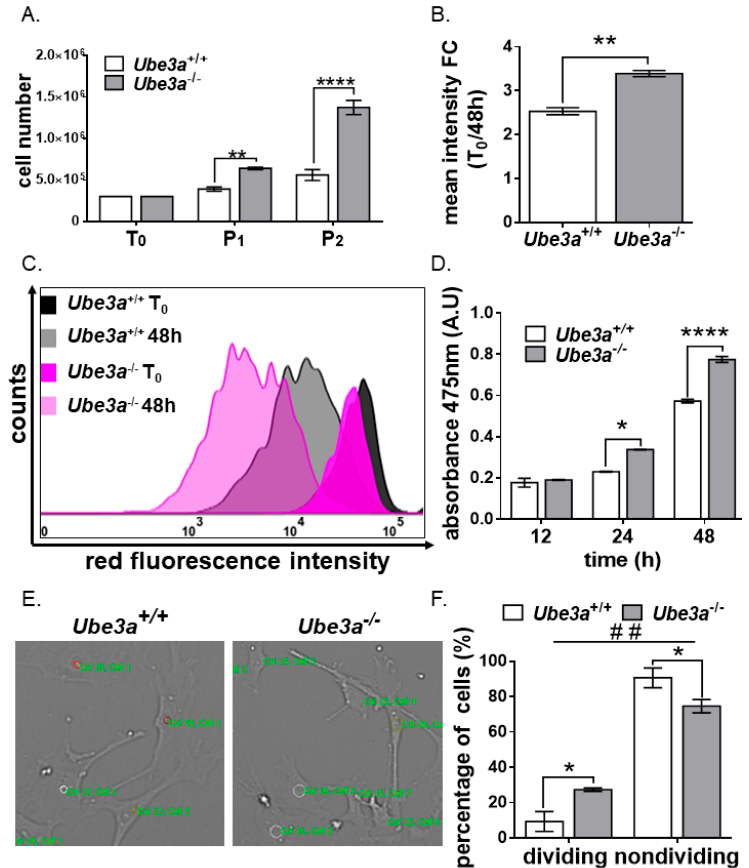
Figure 1. Ube3a deletion enhances the growth capacity of mouse embryonic fibroblasts (MEFs). ( A ) Graph showing the comparison in the counts of cells of at di ff erent time points: Number of cells seeded at starting point (T 0 ) and two consecutive passages, P 1 and P 2 ( n = 4 independent experiments). ( B ) Graph showing the mean intensity signal in Ube3a +/+ and Ube3a − / − MEFs at T 0 and after 48 h ( n = 3). ( C ) Representative figure of the fluorescent intensity decline in Ube3a +/+ and Ube3a − / − MEFs at T 0 and after 48h. ( D ) Graph showing the colorimetric measurements of the cell proliferation XTT assay, displaying di ff erences in the cell viability of Ube3a +/+ and Ube3a − / − MEFs at 12 h, 24 h, and 48 h ( n = 3 per each genotype). ( E ) Representative cell-tracking images of Ube3a +/+ and Ube3a − / − MEFs after 12h. ( F ) Percentage of dividing cells determined by video microscopy-based cell tracking ( n = 75 cells per well, 2 wells per genotype). The data are presented as the means ± SEM (* p < 0.05, ** p < 0.01, **** p < 0.0001, and ## p < 0.01 for interaction of the genotype by division in a two-way ANOVA).